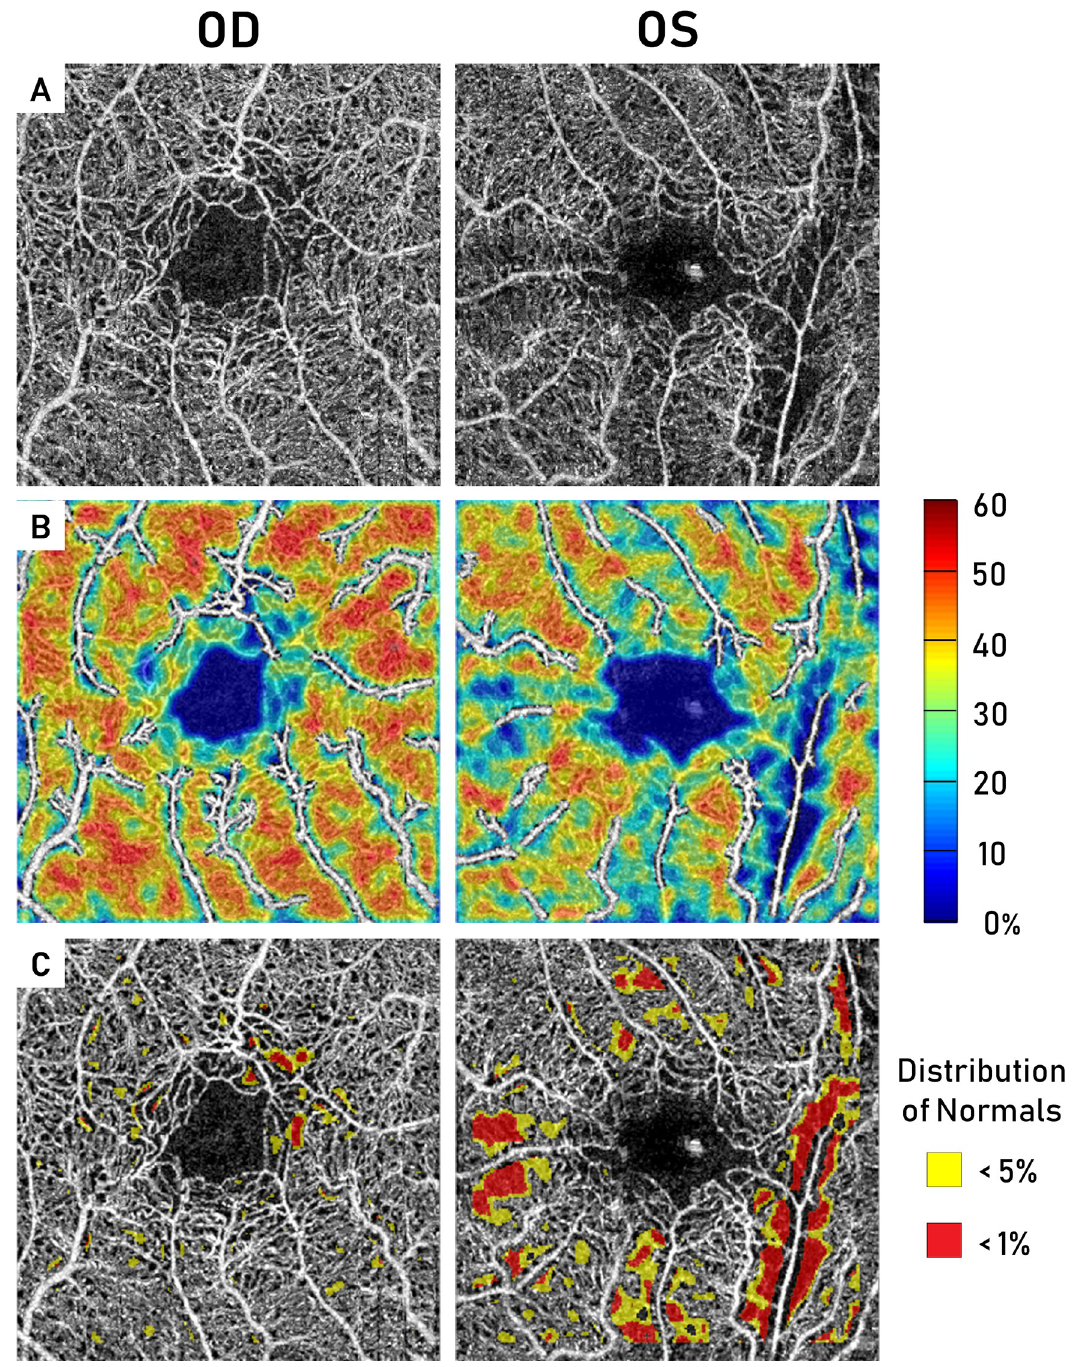
Fig 5. Representative eyes demonstrating interocular asymmetry in a P-SCR patient. Asymmetry is seen between eyes on the A) OCT-A full vascular retinal slabs, B) Parafoveal capillary density maps, and C) Parafoveal capillary density deviation map analysis.